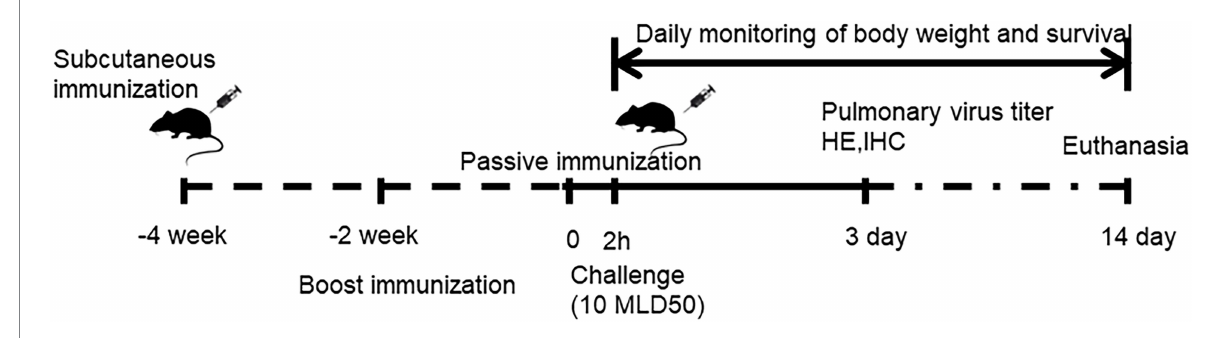
FIGURE 1 Schedule of immunization, sampling and passive immunization effect evaluation in